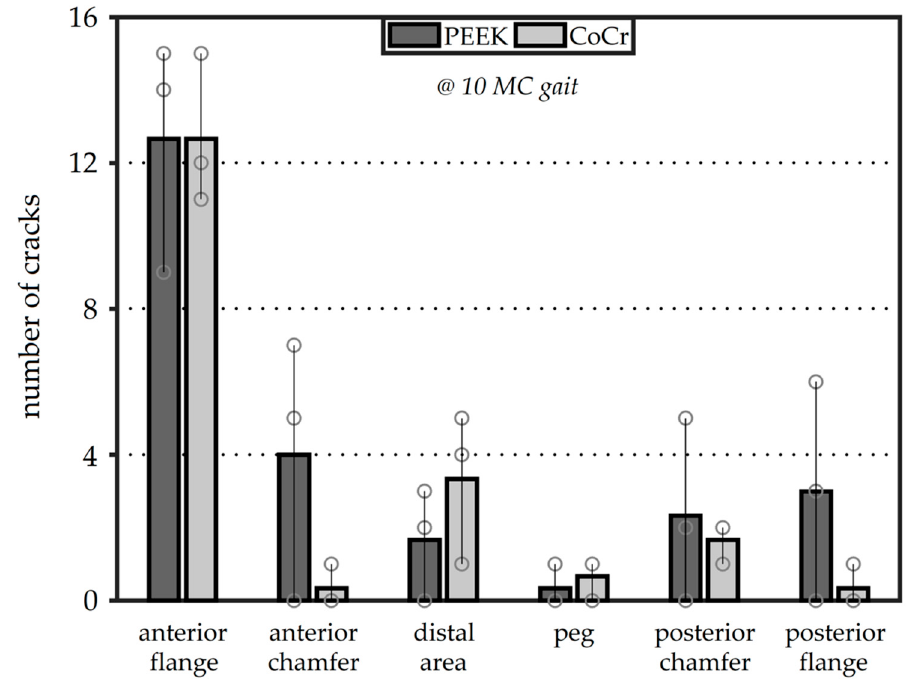
Figure 8. The average number of full-thickness cracks separated for each region after 10 MC. The bars show the range of observations with the individual specimens shown as circles.